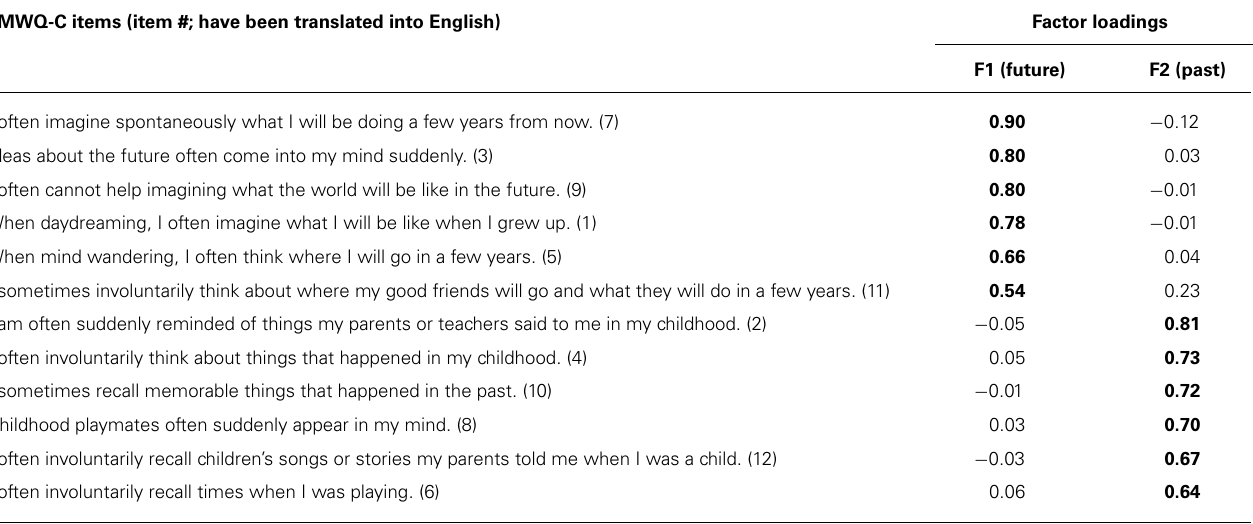
Table 2 | Pattern matrix factor loadings of theTFMWQ-C (oblique rotation method). FMWQ-C items (item #; have been translated into